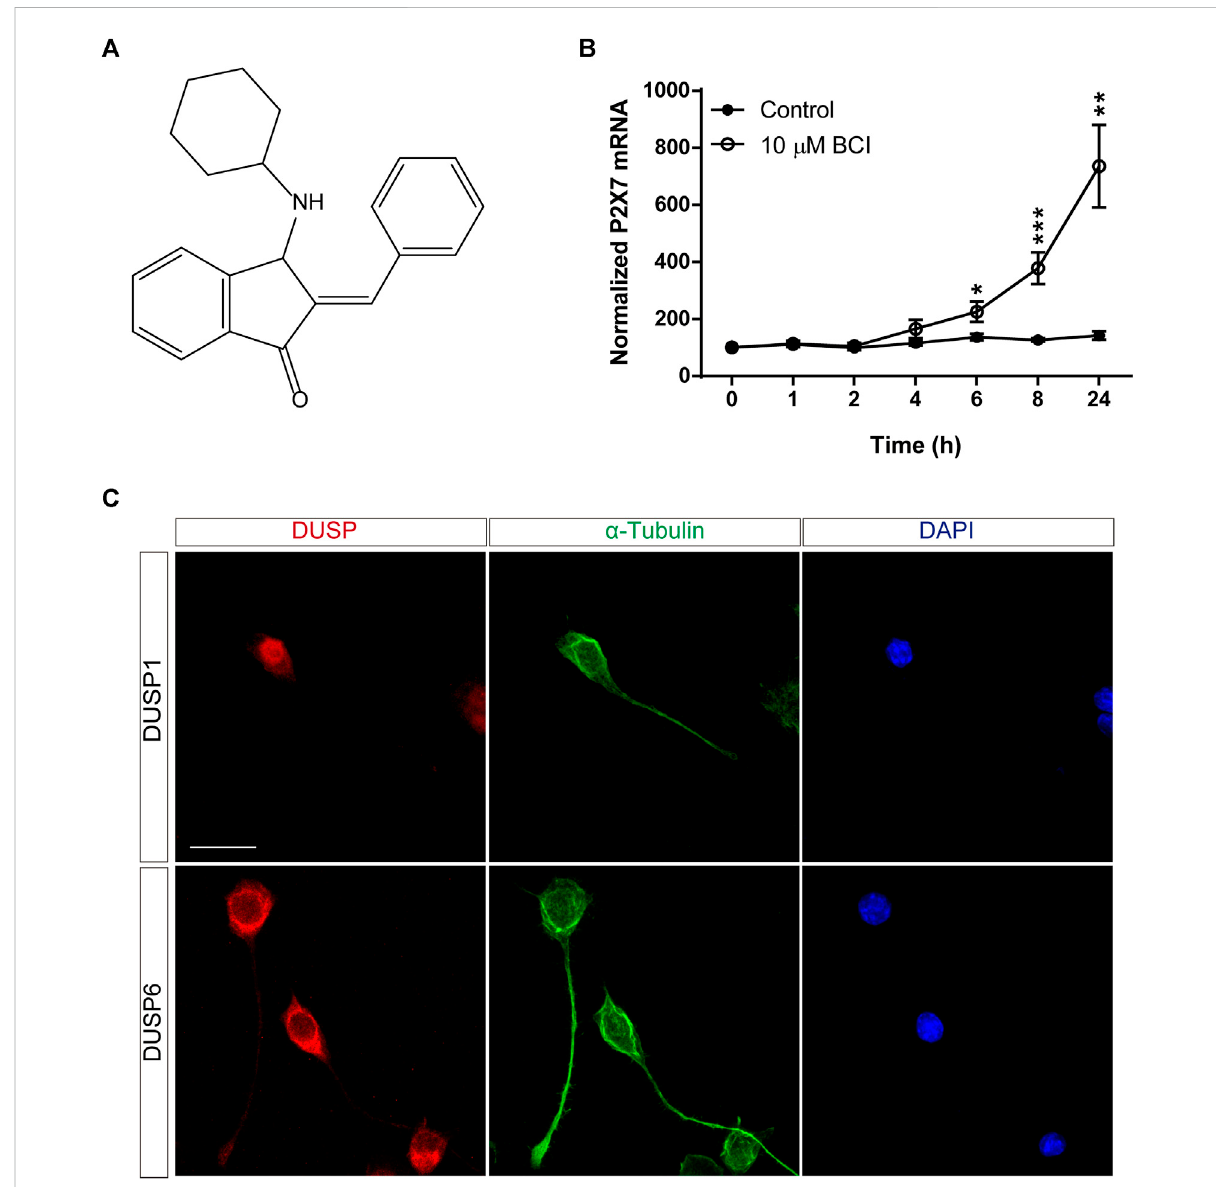
BCI upregulates P2RX7 expression in neuroblastoma cells. (A) Chemical structure of BCI. (B) N2a cells were incubated in SFM for 1, 2, 4, 6, 8 or 24 hinthepresenceofBCI (10 μ M)orinitsabsence (control).TotalRNAwasthenextracted fromthecellsandquanti fi ed.Thedata werenormalized to the P2RX7 transcript levels in cells cultured in complete medium, set as 100% (time = 0). The results are the mean ± SEM of fi ve independent experiments performed in triplicate. * p ≤ .05, ** p ≤ .01, *** p ≤ .001 vs. control. (C) N2a cells cultured for 48 h in SFM, and immunostained for either DUSP1 (upper panel, red) or DUSP6 (lower panel, red) and α -tubulin (green). The nuclei were counterstained with DAPI (blue). Scale bar = 25 μ